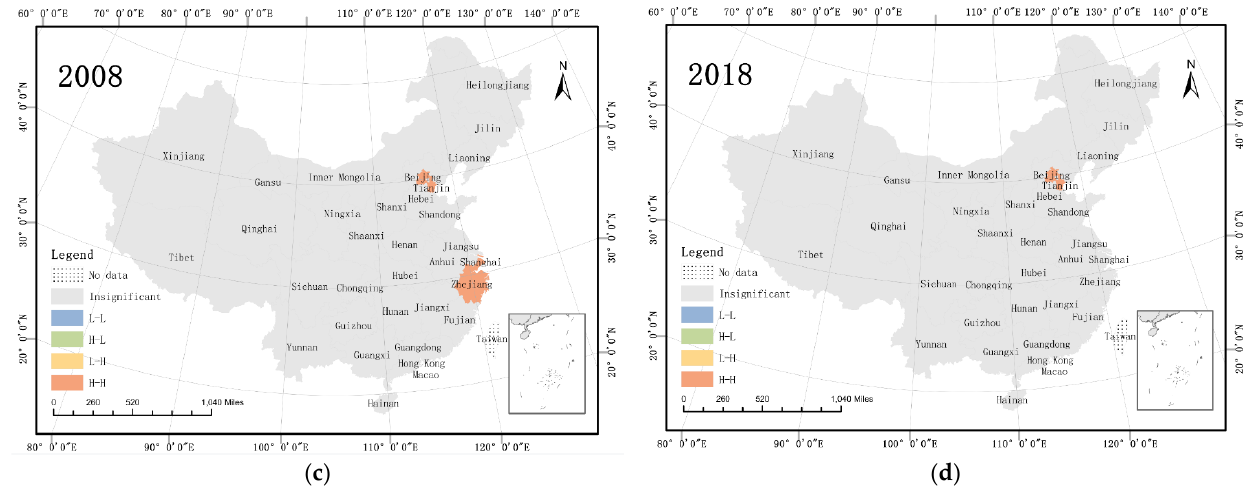
Figure 5. LISA cluster map of agricultural carbon emission intensity ( a , b ) and agricultural patent intensity ( c , d ).